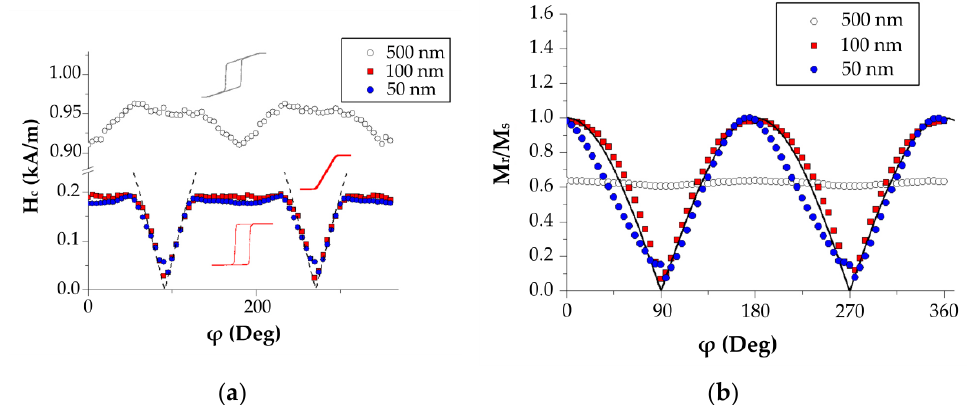
Figure 1. The parameters of the hysteresis loop of permalloy films of various thicknesses: ( a ) coercive force and ( b ) remnant magnetization. The dashed line in ( a ) is the equation H c ( φ ) = H ip | cos ( φ ) | ; the solid line in ( b ) is f ( φ ) = | cos ( φ ) | .